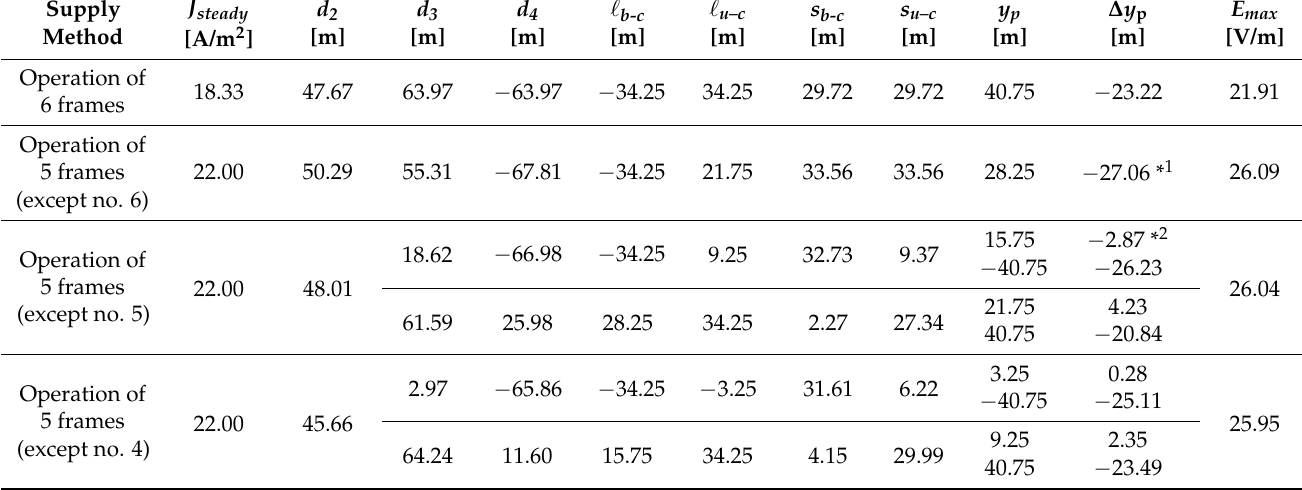
Table 12. Simulation results with method “C”, of a linear current source, for the case of an arrange- ment of 6 linear frames, each consisting of 13 electrodes, for the area of Korakia, Crete ( ρ S = ∞ ,